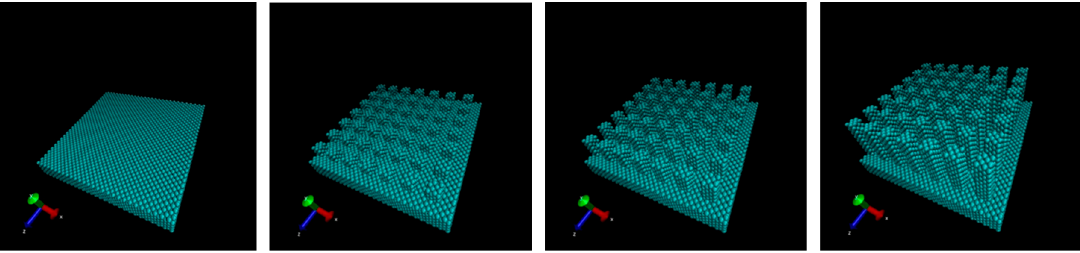
Figure 2. Prepared surface structure. (flat, asperity height 0.724 nm, asperity height 1.448 nm, and asperity height 2.896 nm).